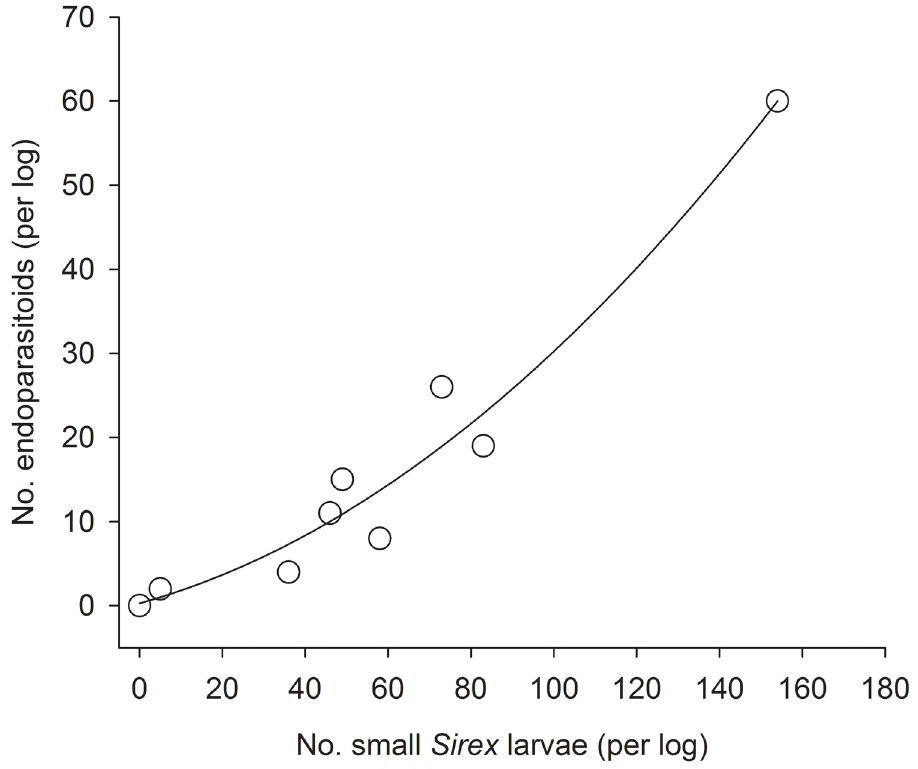
Fig 3. Relationship between number of small Sirex larvae and endoparasitoids from the experimentally-manipulated, exposed cohort. Equation of the fitted line: y = 0.2906 + 0.1365x + 0.0016x 2 ; adjusted R 2 = 0.94; P < 0.001. Each dot represents number of wasps recovered from one log.